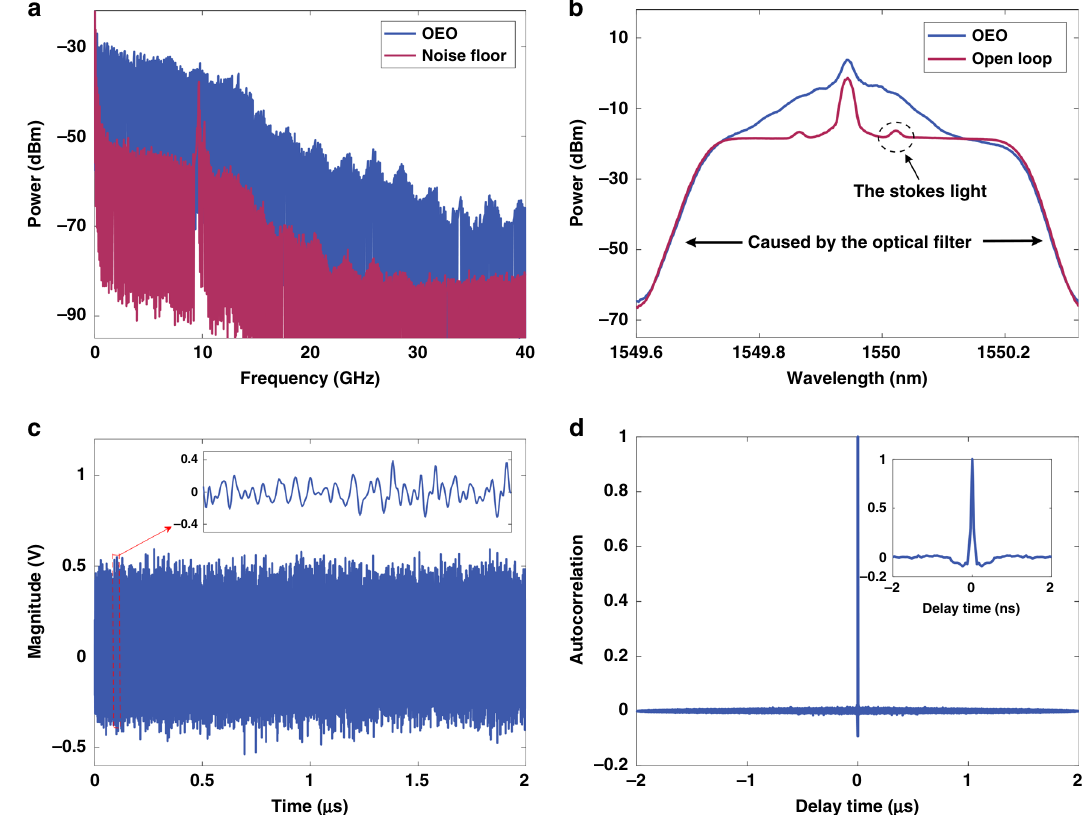
Fig. 4 Experimental results without any radiofrequency fi lter in the link. a The broadband signal spectrum result. Blue: spectrum result of oscillating frequencies in the OEO. Red: the noise fl oor without feedback to the MZM. All the frequencies within the passband (from DC to about 40 GHz) oscillate in the broadband random OEO. The power of the oscillation signals is about 20 dB higher than the noise fl oor. b Optical spectrum measured after the EDFA. Blue: optical spectrum in a closed loop. Red: optical spectrum in open loop (without feedback to the MZM). The optical spectrum is signi fi cantly broadened when the loop is closed, and all frequencies of the broad spectrum are modulated onto the signal light. c Temporal waveform from the OEO. The inset shows a time window of the waveform. No periodicity is seen from the temporal waveform, and its amplitude varies randomly. d Autocorrelation function. The inset shows the expanded view of the center peak. The autocorrelation function has a maximum value at delay time τ = 0 and decays to zero quickly when delay time τ is slightly greater than zero, con fi rming that the generated signal is non-periodic and has approximately white noise (8 – 12 GHz), satellite data links in the Ku-band (12 – 18 GHz) and K-band (18 – 25 GHz), future evolutions of 5 G and 6 G tele- communication systems and next-generation broadband wireless line-of-sight links using carriers from 28 to 35 GHz, etc. Fur- thermore, the oscillation power could be higher with larger